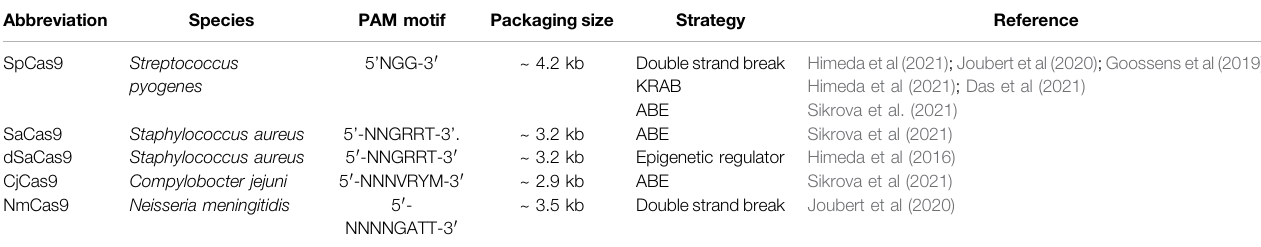
TABLE 2 | Characteristics of the Cas9 used in the different therapeutic approaches for